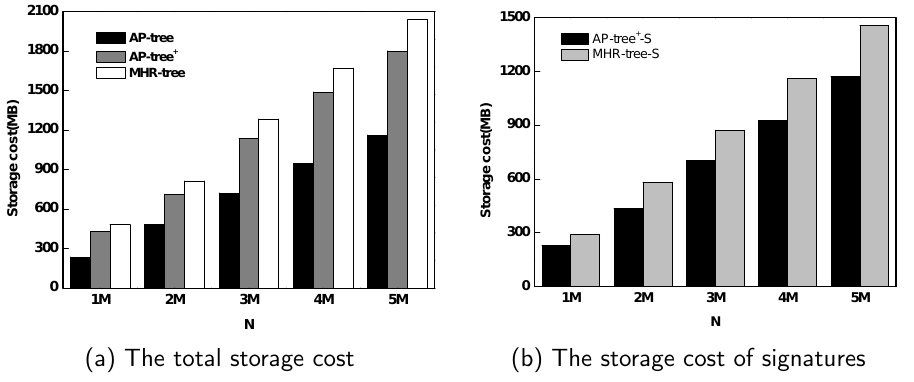
Figure 7. The space cost of AP-tree + based on TWEET dataset.